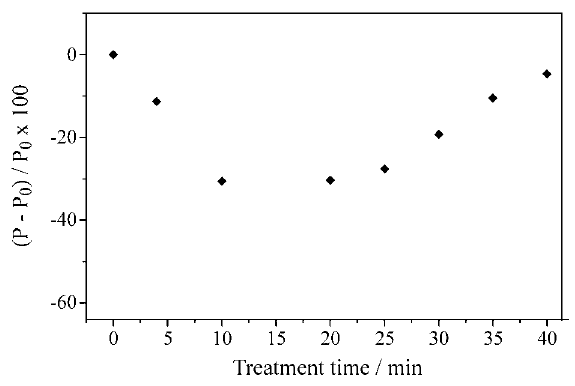
Figure 3. Nitrogen percentual variation permeability through ultrafiltra- tion PSf membranes after argon plasma treatment, at 5 W.